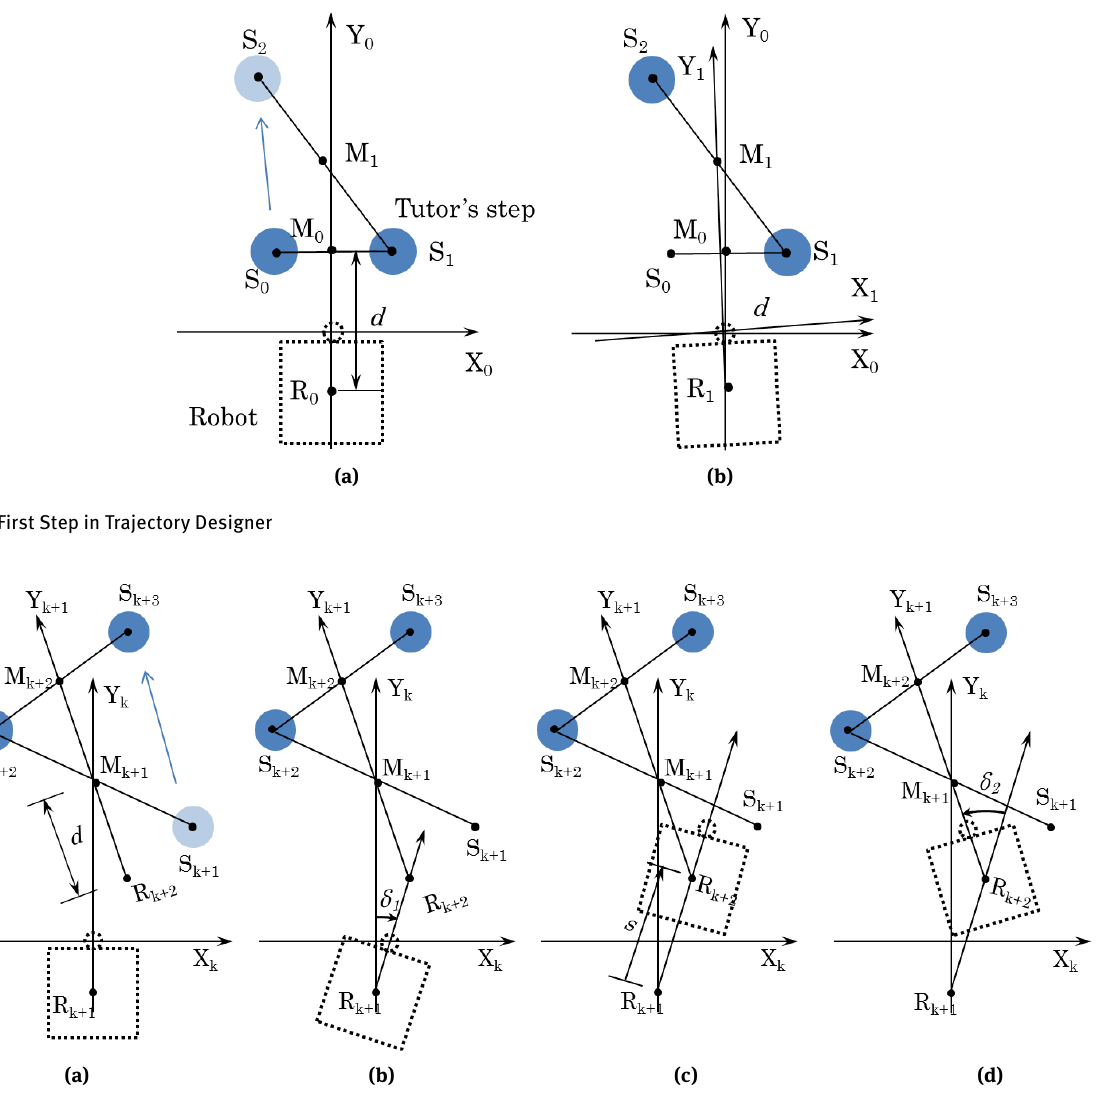
Fig. 14. Other step in Trajectory